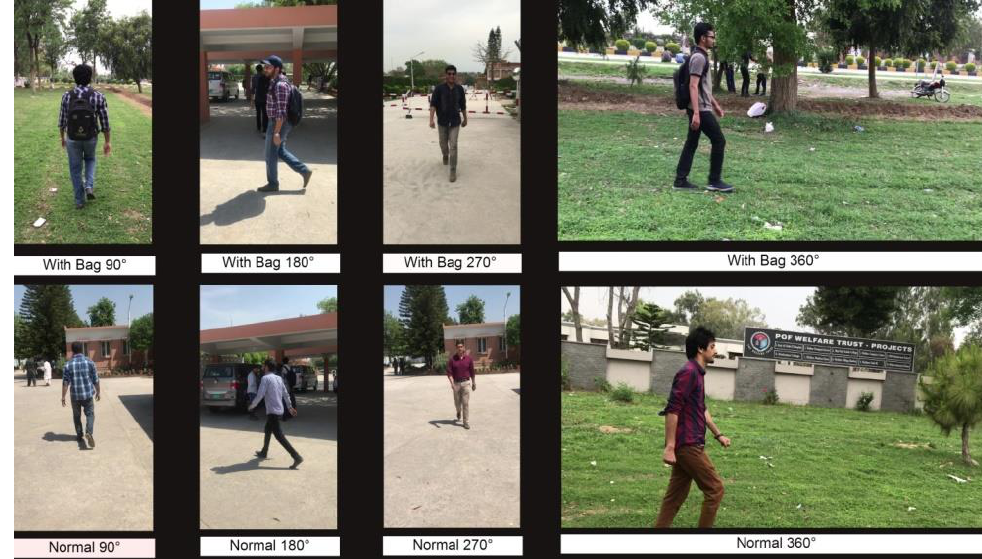
Figure 6. Sample image frames of real-time video sequences.